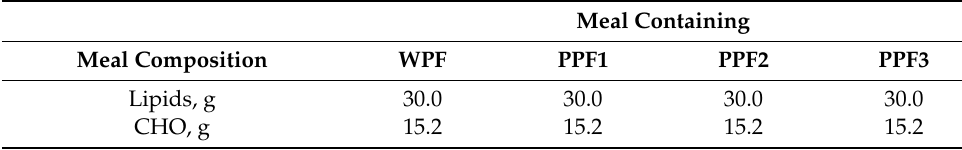
Table 1. Test meal nutritional compositions 1